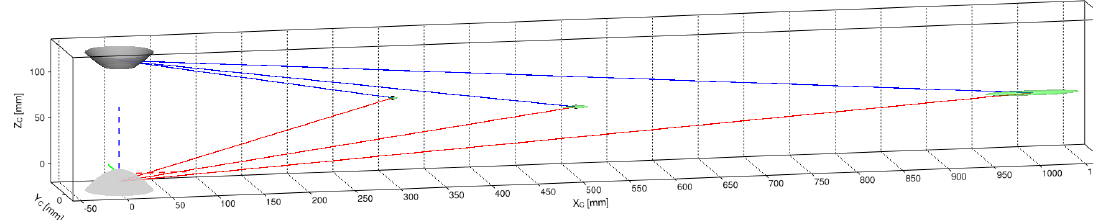
Figure 19. Uncertainty ellipsoids for triangulated points at ranges ρ w ≈ { 0.3,0.5,1.0 }